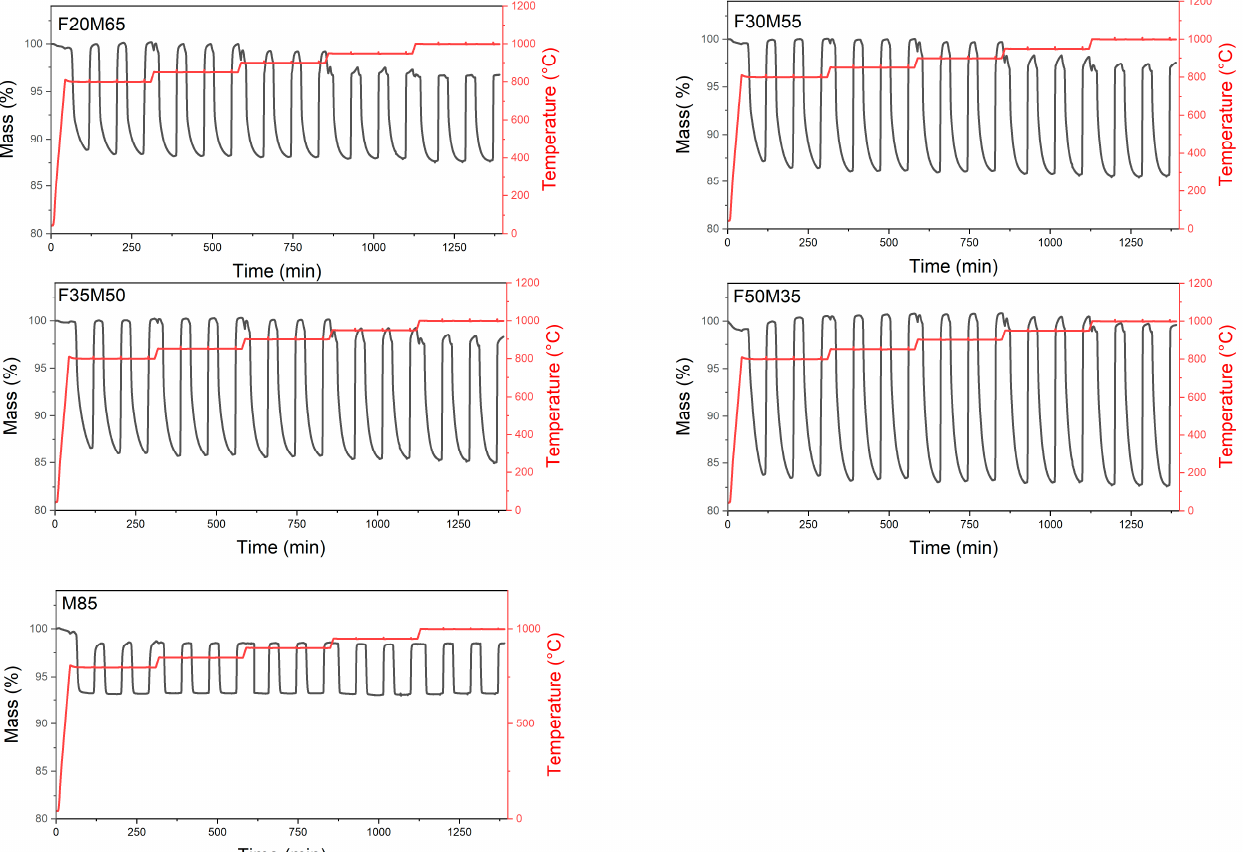
Figure 3. Thermogravimetric measurement data for cycling redox tests: 4% H 2 /Ar was used for the reduction, while 20% O 2 /N 2 was used for the oxidation reactions.